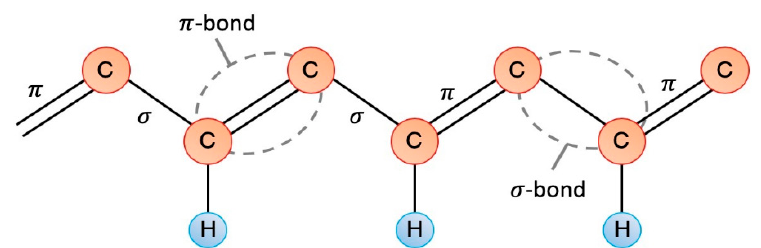
Figure 5. Diagram of the conjugated chain of an intrinsically conductive polymer. Based on reference [35].